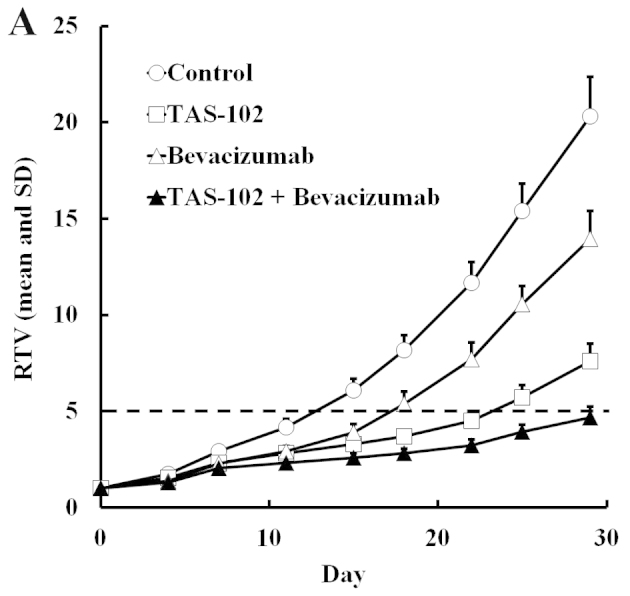
Relative volume change in human HCT116 colorectal tumors (A) and body weight change in HCT116 tumor-bearing nude mice (B). Mice were treated with vehicle (○), TAS-102 (□), bevacizumab (△), or combined TAS-102 and bevacizumab (▲). The values indicate the means + SD (n=6). The horizontal dotted line indicates an RTV of 5. RTV, relative tumor volume.